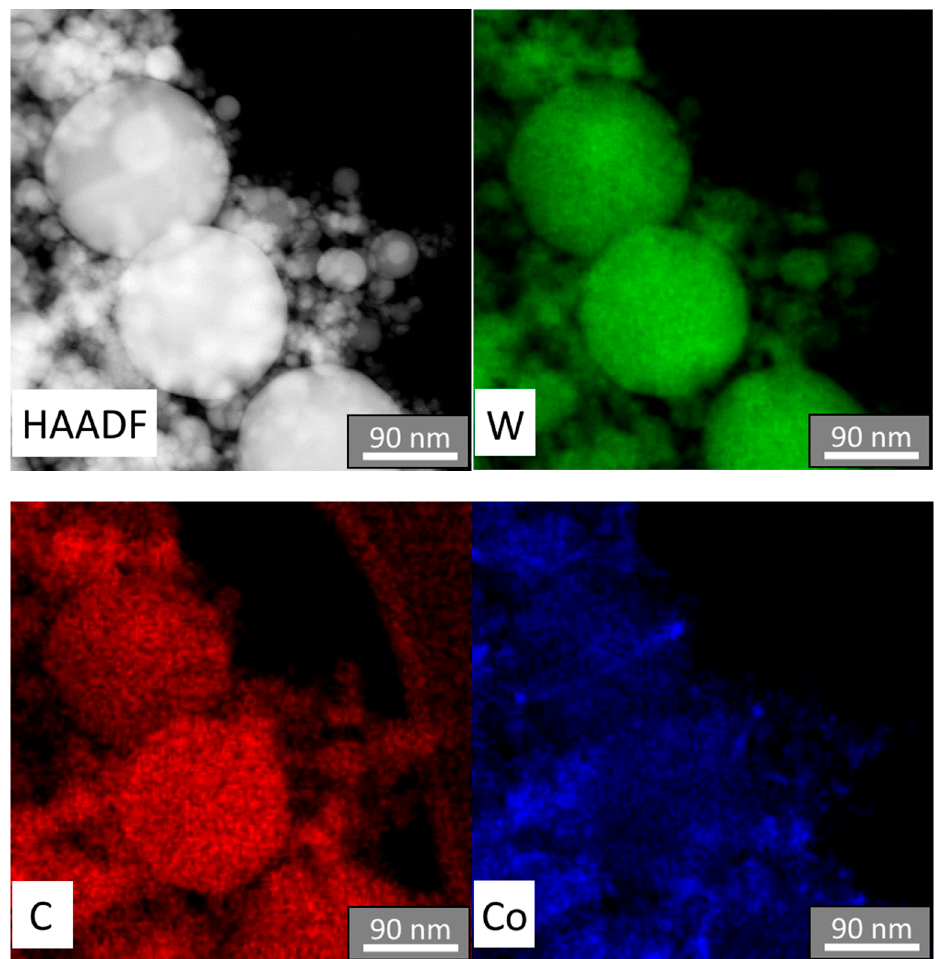
Figure 3. Results of the EDS microanalysis with element distribution maps (W, C, Co) among particles of W-C-Co composite nanopowder.